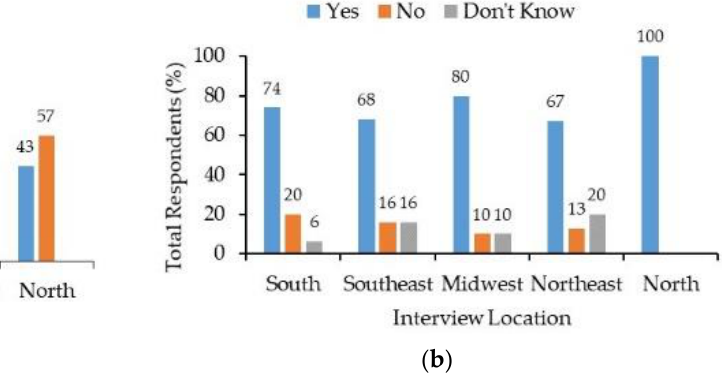
Figure 3. Perception of use and occupation of the plot area by towers and roads ( a ) and perception about the suppression of vegetation in the lot and villages ( b ) according to the total number of interviewees by region. Source: elaborated by the